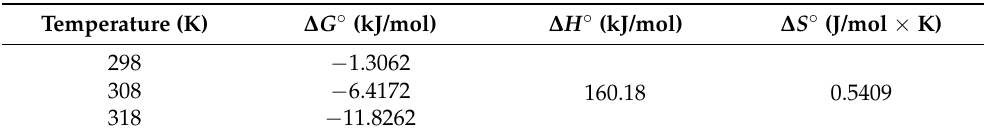
Table 4. Thermodynamic parameters for Sb (III) adsorption by HI/ABsep.